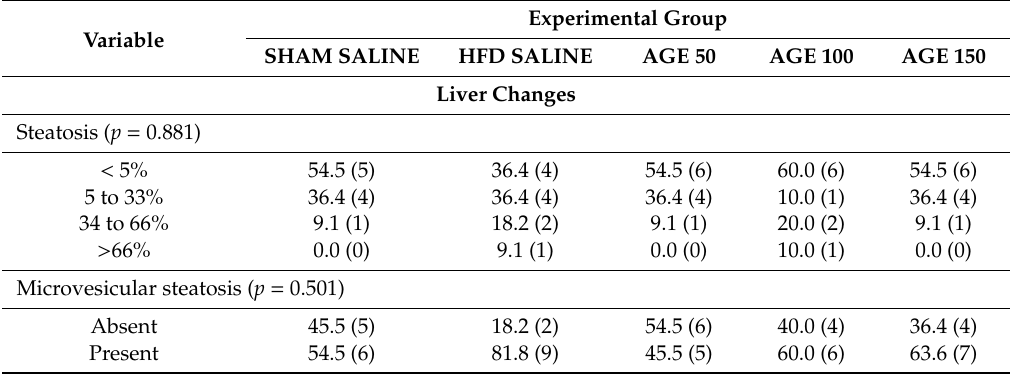
Table 6. Results for changes observed in the liver of animals in each experimental group.